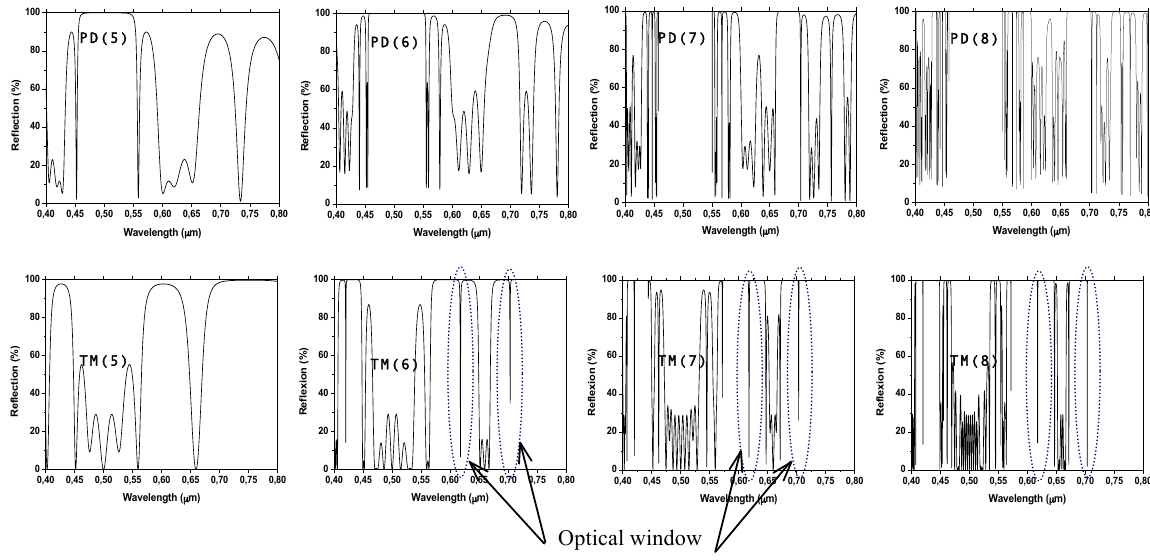
Figure 4: Reflection spectrum versus the multilayer structure according to the distribution of Period-­‐Doubling and Thue-­‐Morse distributions for the 5 th , 6 th , 7 th , 8 th , generations. To study the polarization effect we plotted the reflection spectra of multilayer systems according to the distributions of Period-Doubling and Thue-Morse, depending on incidence angle θ (rad) of the polarized wave in TE and TM modes (fig.6 and fig.7). And then projecting the spectrum on the (oxy) plane to find the band gap, the white areas represent propagation bands, and the blue areas forbidden bands, where R > 99.9 %. And we chose the 5 th generation of the sequences of Thue-Morse TM (5) and Period-Doubling PD (5) (Fig.6 and Fig 7).